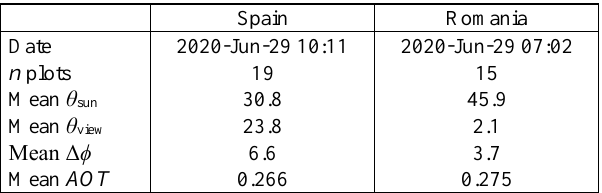
2.3 Retrieval of vegetation parameters In order to calculate functional diversity metrics from estimates of vegetation parameters, we constrained an RTM with DESIS reflectance factors within a 3-by-3 pixel window centered on each plot. Vegetation parameters were retrieved by inverting the optical RTM of the model SCOPE (van der Tol et al., 2009). In addition, to fit the observed reflectance factors, soil parameters of the SCOPE’s model BSM were also estimated (Table